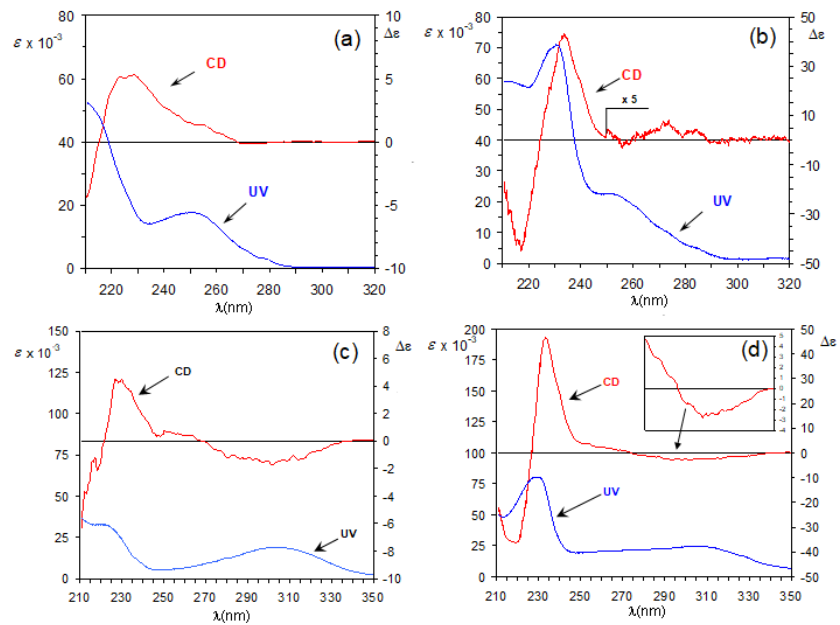
Figure 9. UV and ECD spectra (THF) of biphenylamides ( R )- 5aa panel ( a ), ( R )- 5ba panel ( b ), ( R )- 5ac panel ( c ) and ( R )- 5bc panel ( d ).